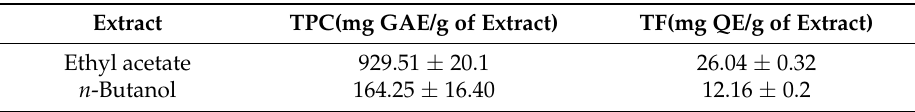
Table 2. Phenolic compounds of Euphorbia dendroides extracts. Extract